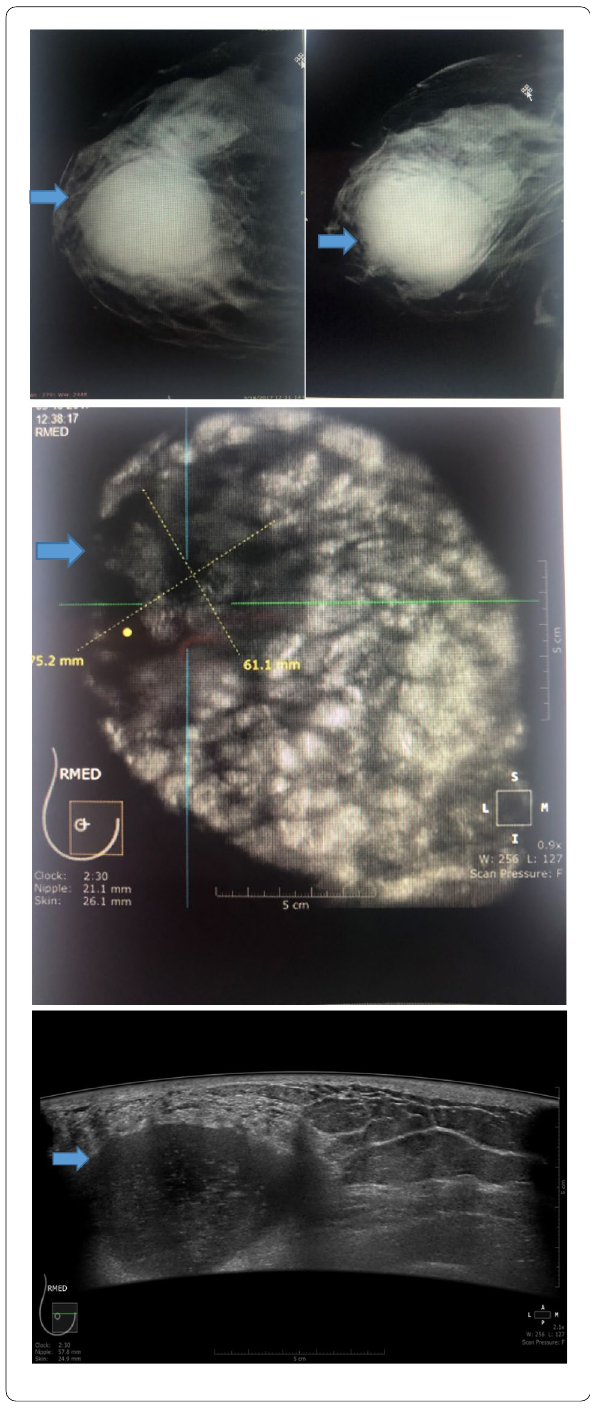
Fig. 5 A 42-year-old female patient presenting with tender right breast. Tomosynthesis CC and MLO views of the right breast confirmed the previously described mammographic findings (not shown), however, with less fibroglandular tissue overlap and thus better delineation of the margins (BIRADS III). Automated ultrasound right medial coronal image shows a large defect at 2:30 o’clock. Automated ultrasound right medial axial image shows a right oval-shaped mass with indistinct margin, parallel orientation and hypoechoic echo genic cyst (BIRADS III). The lesion was proved to be inflammatory mastitis with acute abscess formation by aspiration of the abscess content. Automated ultrasound was superior to tomosynthesis in predicting the exact